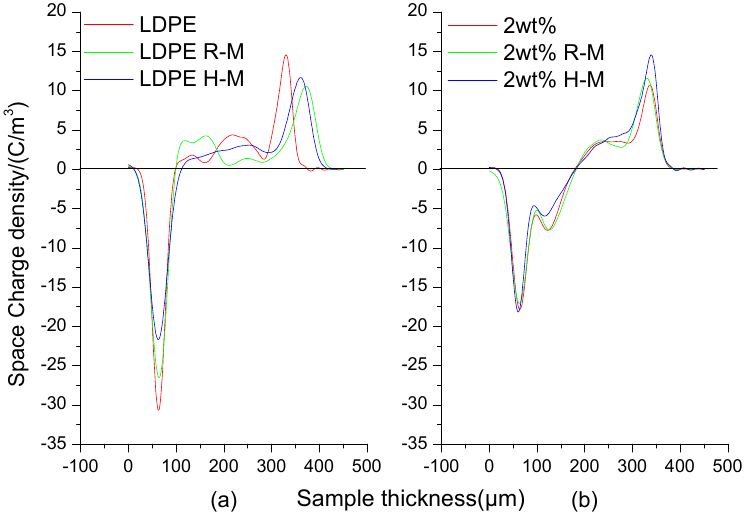
Figure 9. Test curve at 40 KV showing the space charge of LDPE ( a ) and composites ( b ) at different magnetization temperatures. ( a ) is the space charge curve of LDPE. ( b ) is the space charge region curve of the BiFeO 3 /LDPE composite. Curves LDPE and 2 wt% indicate no magnetization treatment. R-M is room temperature magnetization. H-M is high temperature magnetization.